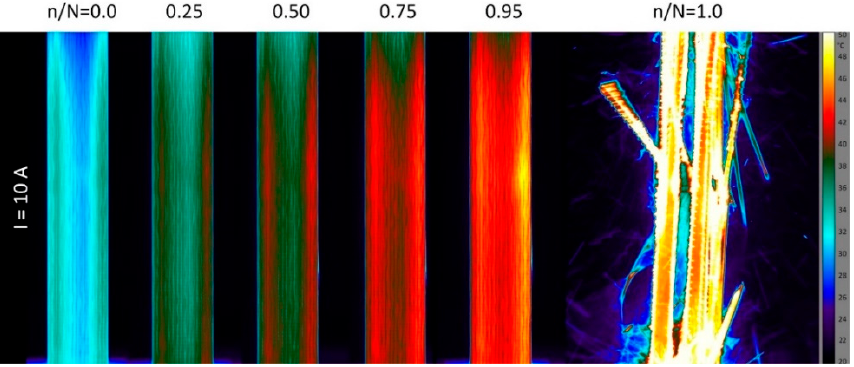
Figure 27. Thermographic image series of a current-carrying specimen (10 A) under a high fatigue load (997 MPa).